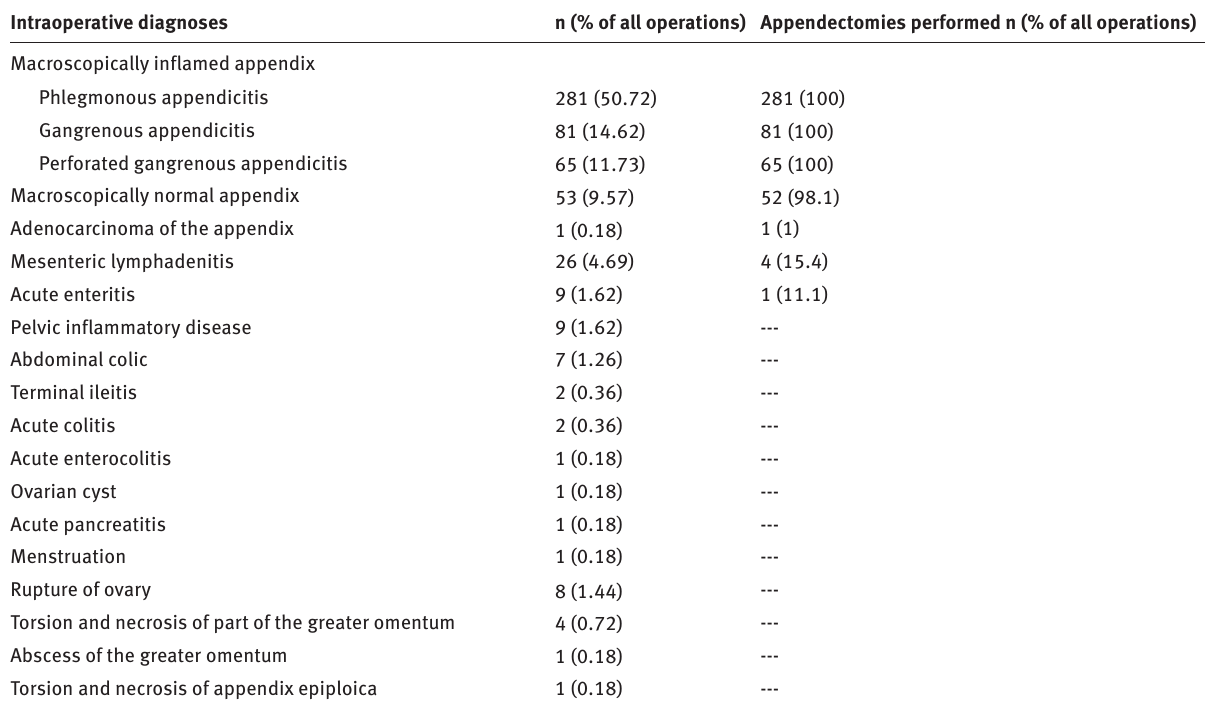
Intraoperative diagnoses n (% of all operations) Appendectomies performed n (% of all